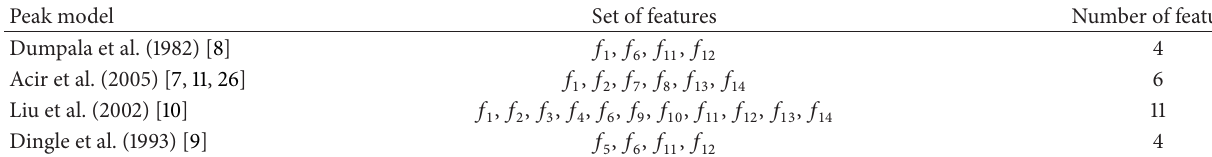
Table 3: List of different peak models and sets of features.